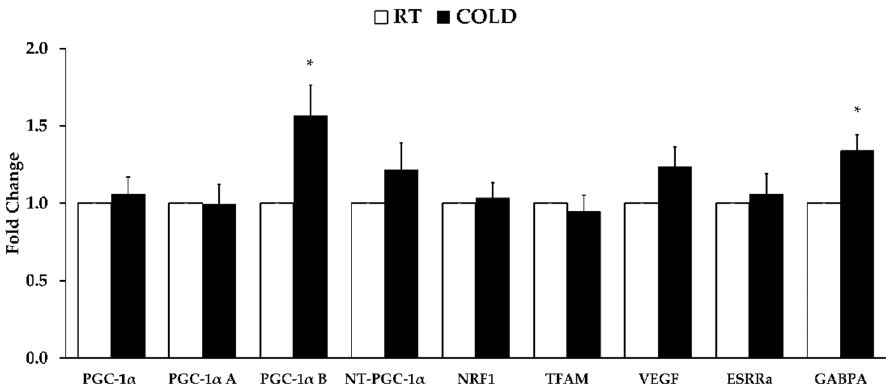
Figure 1. Skeletal muscle mitochondrial biogenesis-related messenger RNA expression 4 h post cold application. Shown genes include: Peroxisome proliferator-activated receptor gamma coactivator 1 alpha ( PGC-1 α ), PGC-1 α A , PGC-1 α B , Truncated PGC-1 α ( NT-PGC-1 α ), nuclear respiratory factor 1 ( NRF1 ), transcription factor A mitochondrial ( TFAM ), vascular endothelial growth factor ( VEGF ), estrogen-related receptor α ( ERR α ), and GA-binding protein transcription factor Alpha Subunit ( GABPA ). Data are mean ± SE. * p < 0.05 from RT.